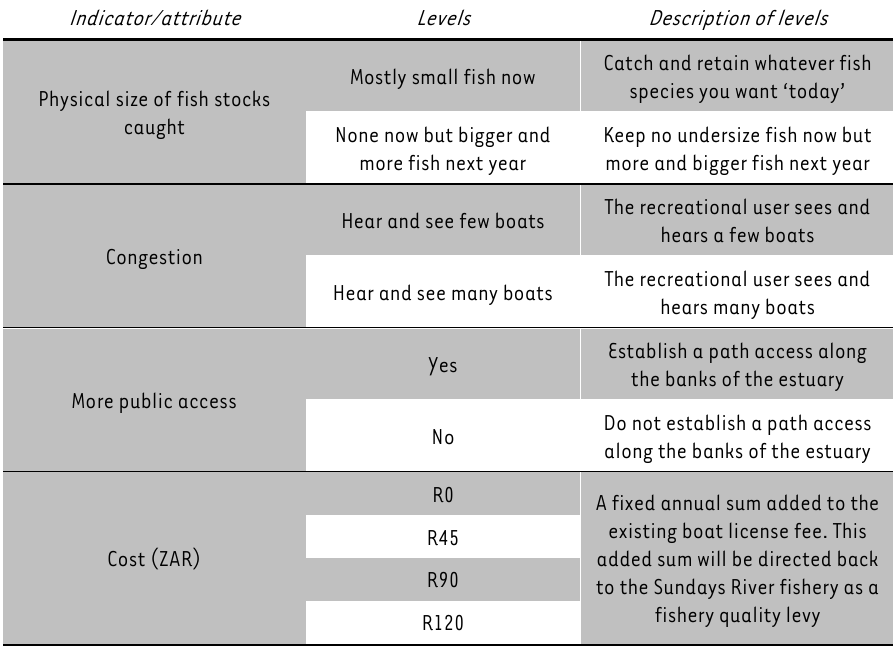
TABLE 2: The CE attributes and their